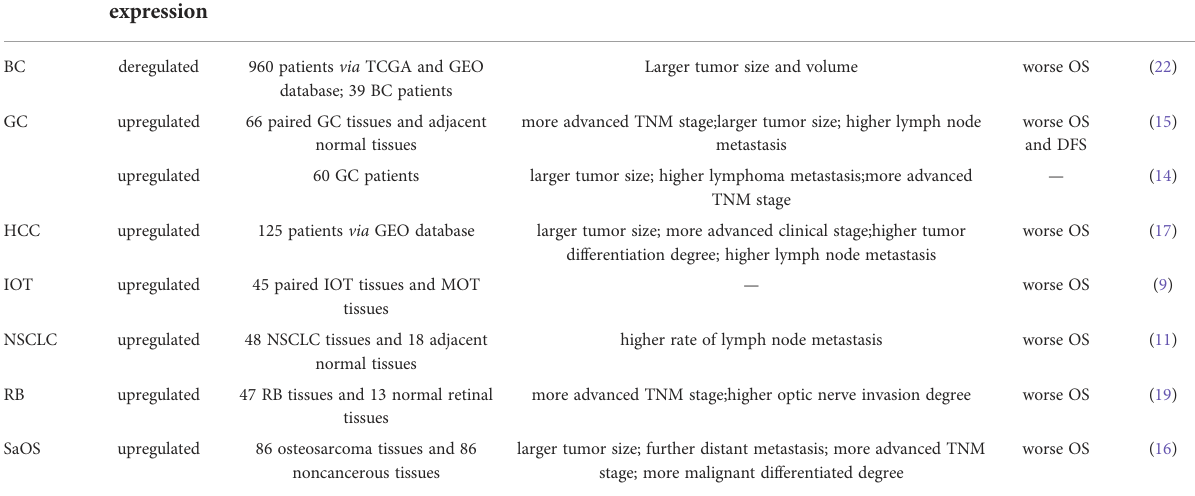
TABLE 3 Clinicopathological and prognostic values of LINC00324 in cancer.